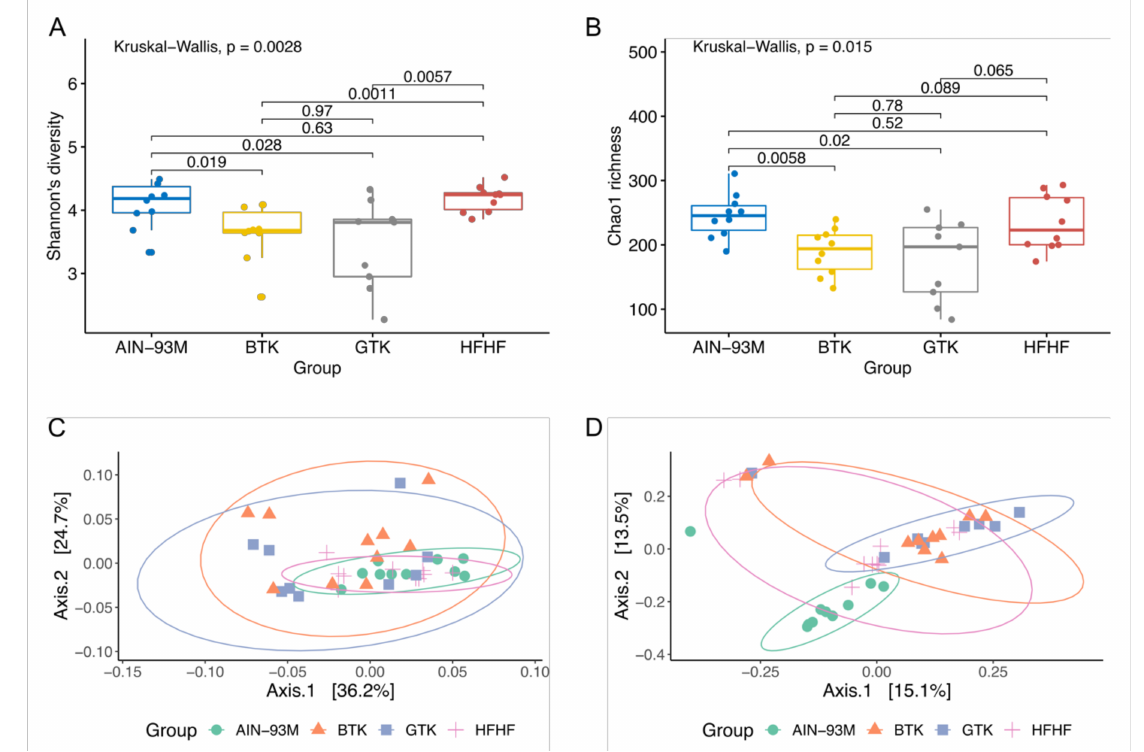
Figure 4. Box and whisker plots comparing species diversity ( A ) and richness ( B ) among the groups AIN-93M, BTK, GTK, and HFHF at the end of the experimental period. Horizontal bold lines show the median values. The bottom and top of the boxes show the 25th and the 75th percentiles, respectively. The whiskers extend up to the most extreme points within 1.5 times the interquartile ranges (IQR). Principal coordinate analysis (PCoA) based on weighted ( C ) and unweighted ( D ) UniFrac distances. PERMANOVA with 999 permutations was used to detect significant differences between microbial communities (dissimilarity) of different experimental groups. Standard error ellipses show 95% confidence